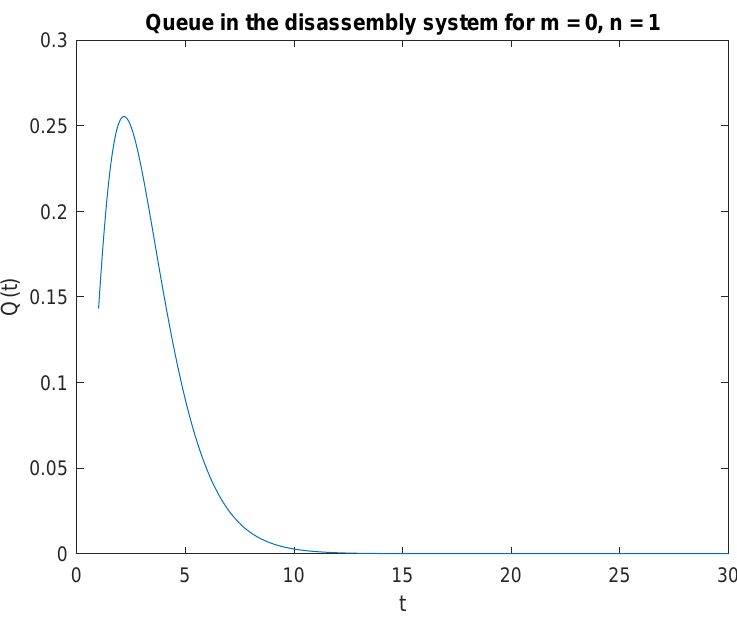
Figure 2. Impact of buffer state on probability P { X ( t ) = m = 0 | X ( 0 ) = n = 1 } . Note that the probability P { X ( t ) = 1 | X 0 = 0 } is highest right after the system is opened (Figure 3). This is due to the fact that the system starts disassembly as soon as it is opened. The disassembly system immediately goes into the vacation mode due to lack of disassembly tasks. After 2.2 s, the probability of a job, P { X ( t ) = 1 | X 0 = 1 } drops to zero after 14 seconds of simulation (Figure 4).